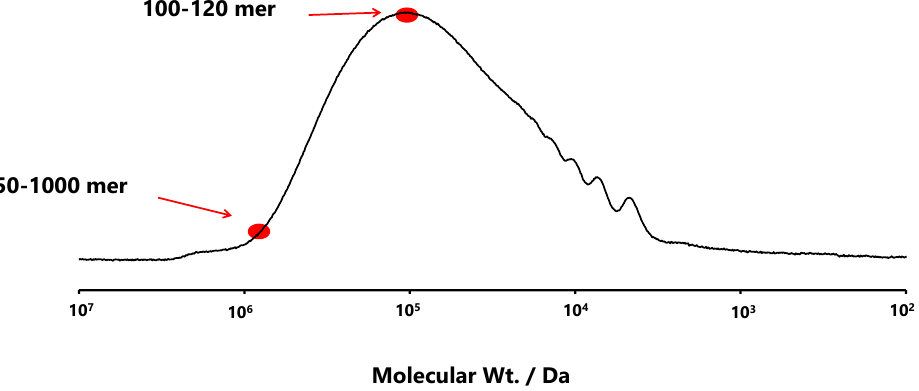
Figure 1. Analytical GPC chart of porphyrin polymer in THF, at room temperature, using a standard polystyrene calibration curve. The arrows refer to the formation of ~ 100–120 and 950–1000 mer at around 10 5 and 10 6 Da, respectively.